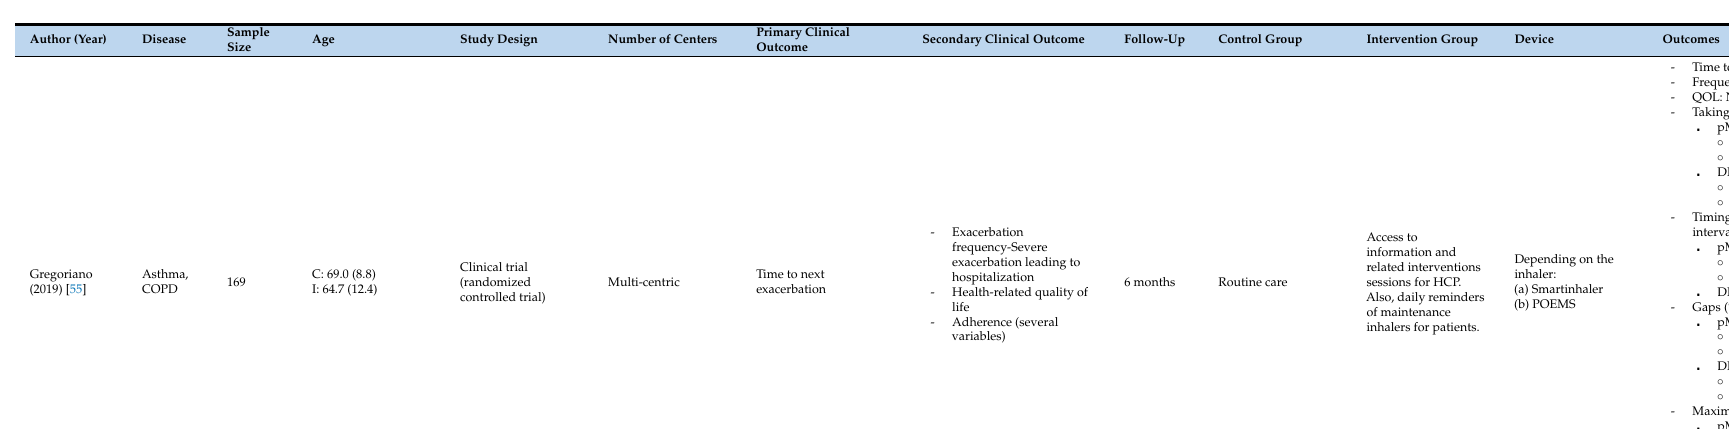
inhalersforpatients.